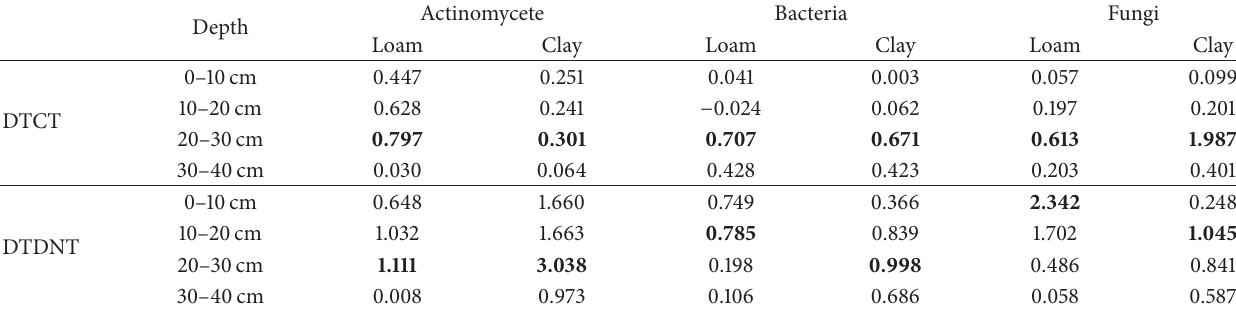
Table 2: DTCT and DTDNT values of soil microorganism in the loam and clay soil.